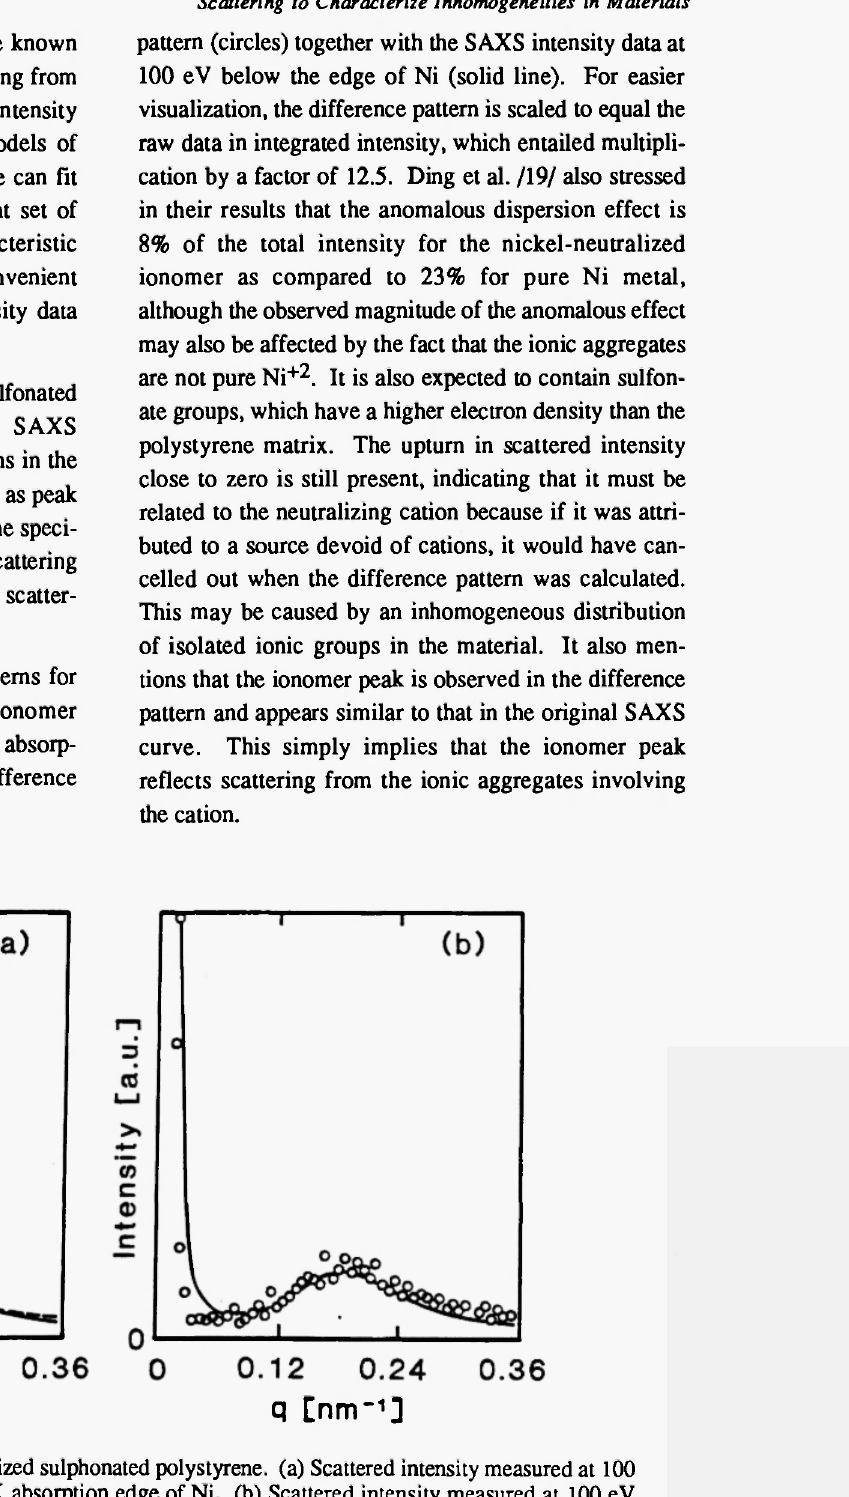
Fig. 15: SAXS curves for nickel-neutralized sulphonated polystyrene, (a) Scattered intensity measured at 100 (—) and 5 eV (- -) below the Κ absorption edge of Ni. (b) Scattered intensity measured at 100 eV (—) below the edge and difference pattern of curves shown in Fig. 15a represented by circles. The difference pauern has been scaled to equal the solid curve in integrated intensity /19/.